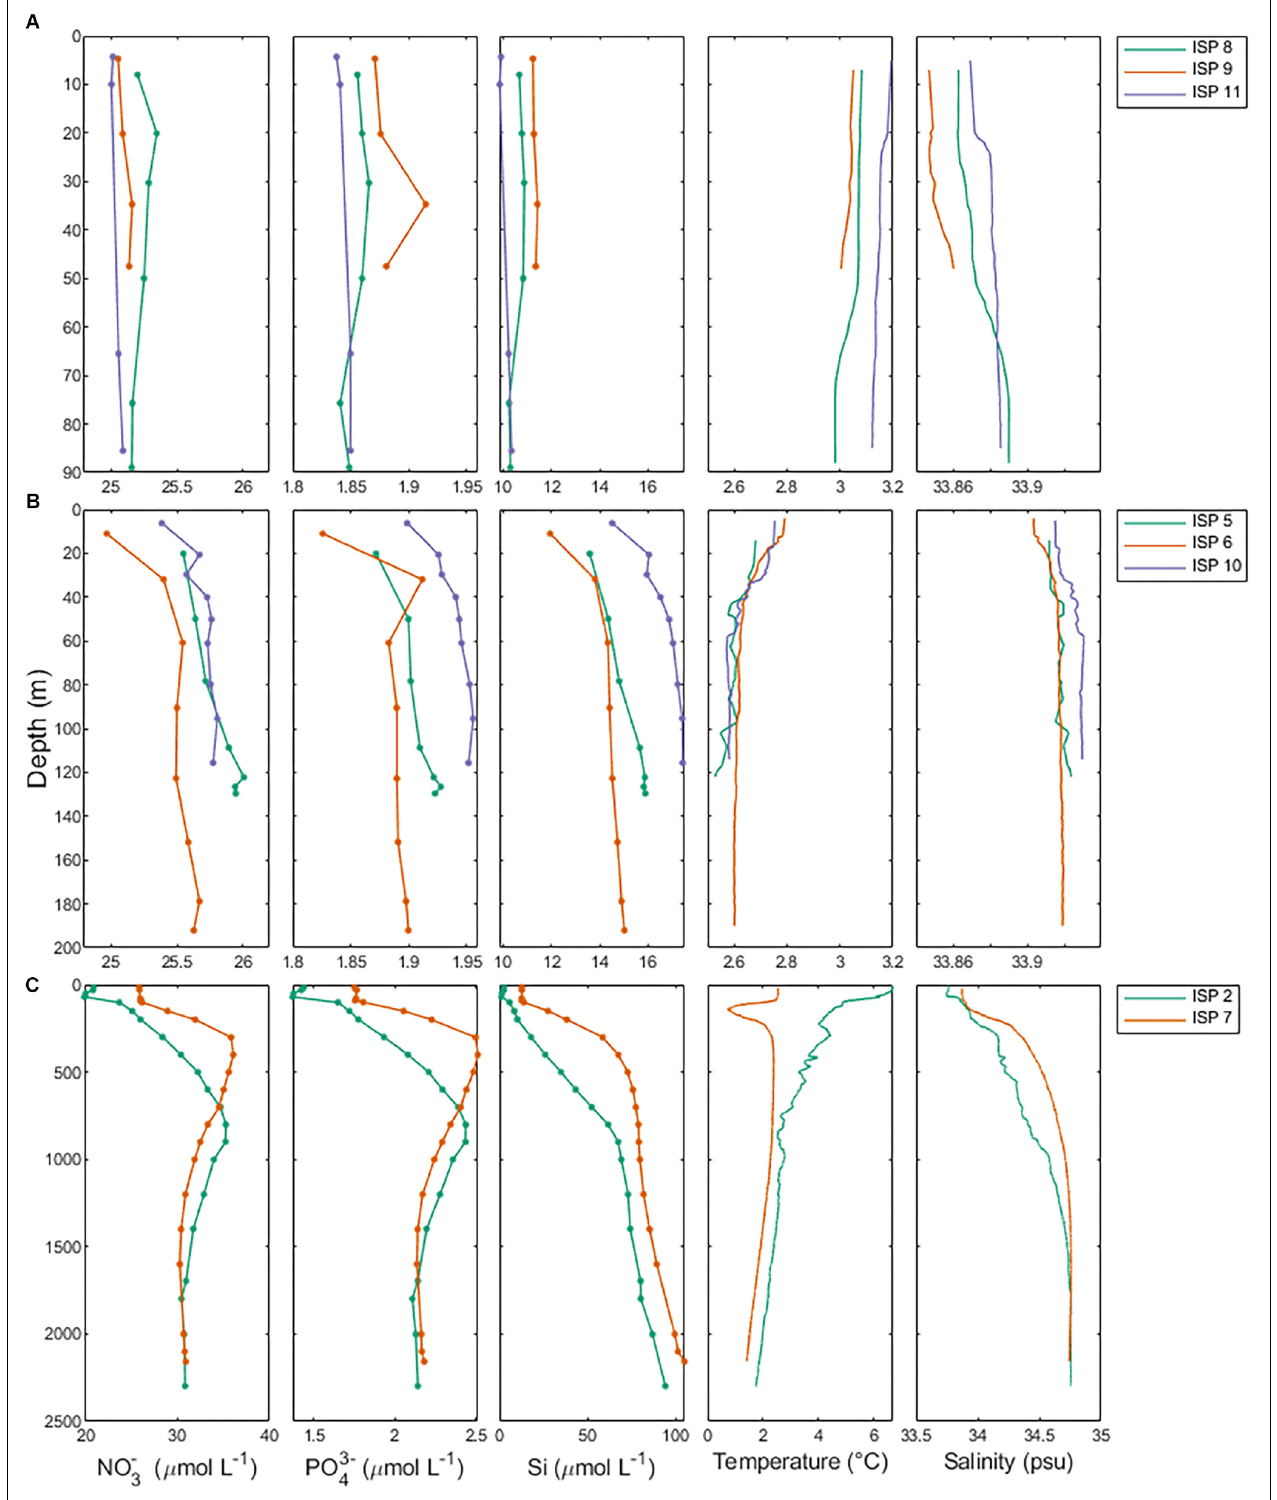
FIGURE 8 | Macronutrient, temperature and salinity profiles separated by study region. Row A (ISP8, 9, and 11) is Heard Island, row B (ISP5, 6, and 10) is McDonald Island and row C (ISP2 and 7) are the reference stations.